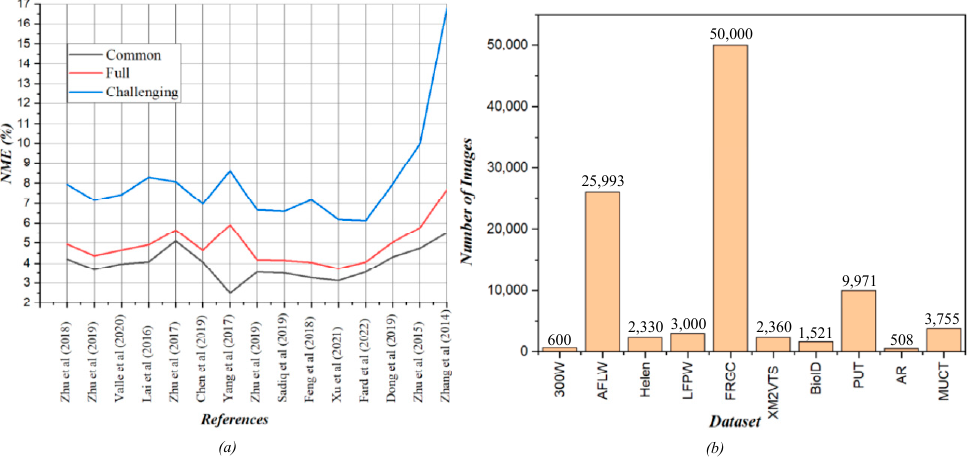
Figure 4. ( a ) NME description of the studies surveyed on a 300W dataset [4,13,15,39–41,43,47,50– ( b ) the number of datasets published in the 55,62]; ( b ) the number of datasets published in the studies.